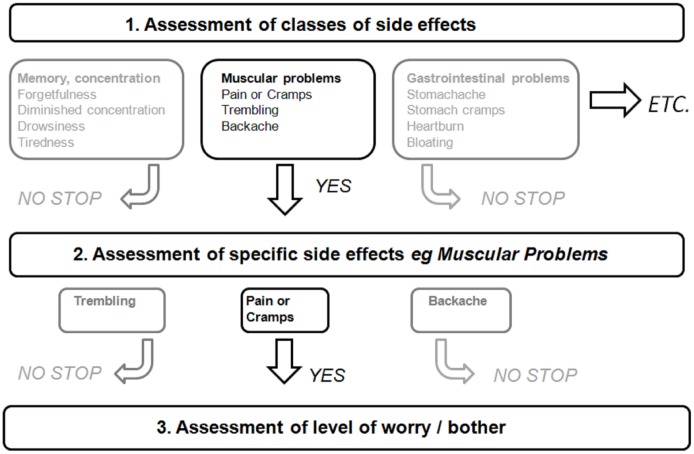
Example of tailored examination with the TMI.